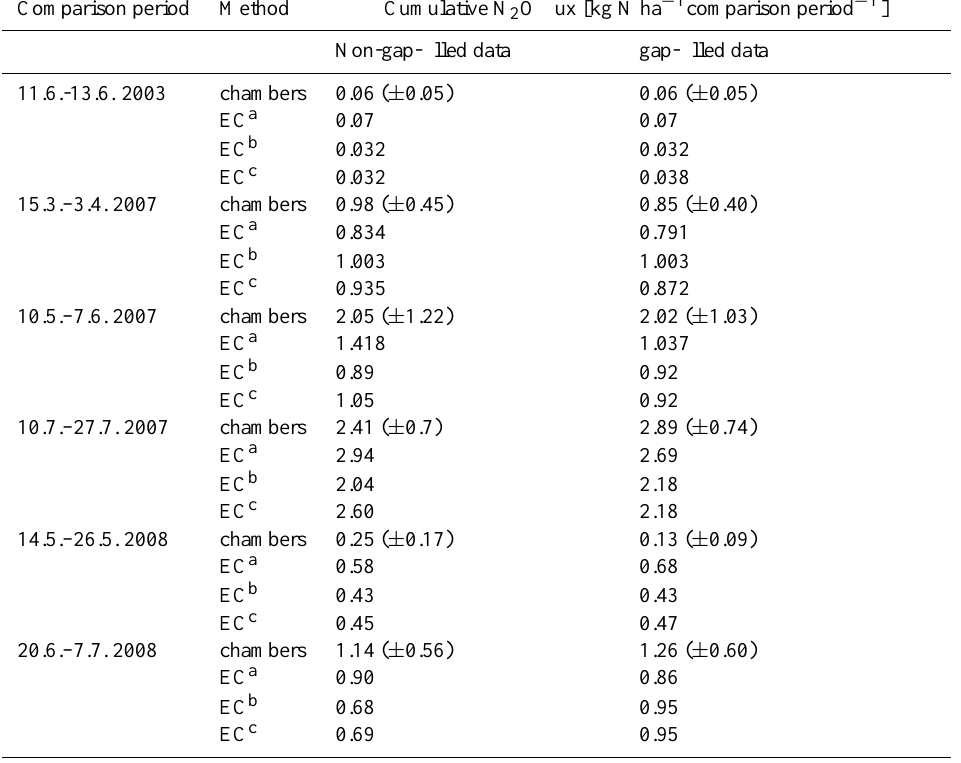
Table 3. Cumulative N 2 O fluxes from chambers and eddy covariance for all 6 periods. Fluxes were calculated using both non gap-filled and gap-filled data. Values in brackets represent standard deviations amongst 14 (2003) or 4 (2007/2008)